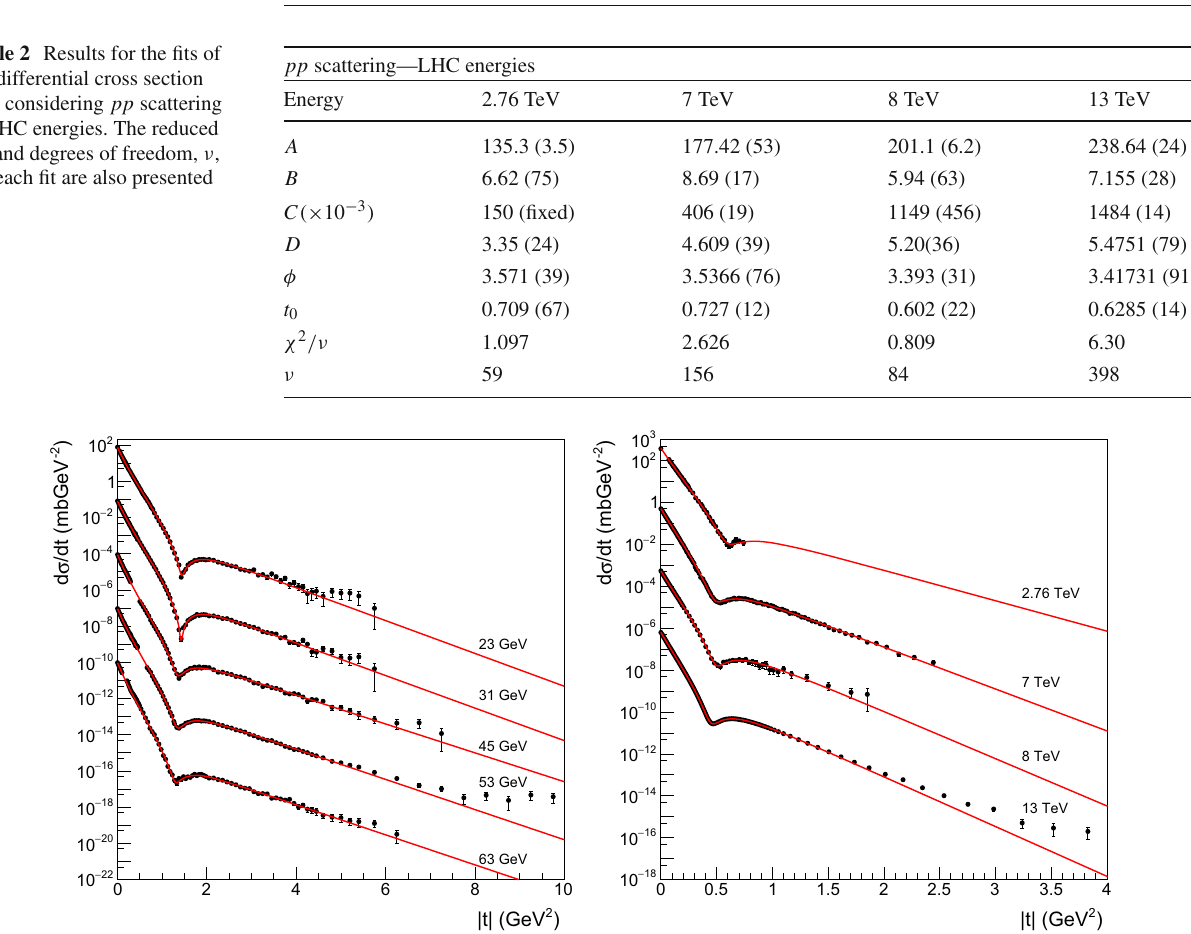
Fig. 1 Comparison between the PB results and the experimental data for d σ/ dt in pp collisions at ISR (left) and LHC (right)